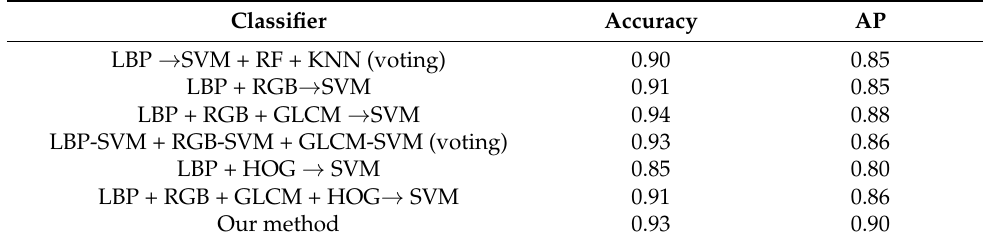
Table 2. Compared with ensemble classifier or multi feature